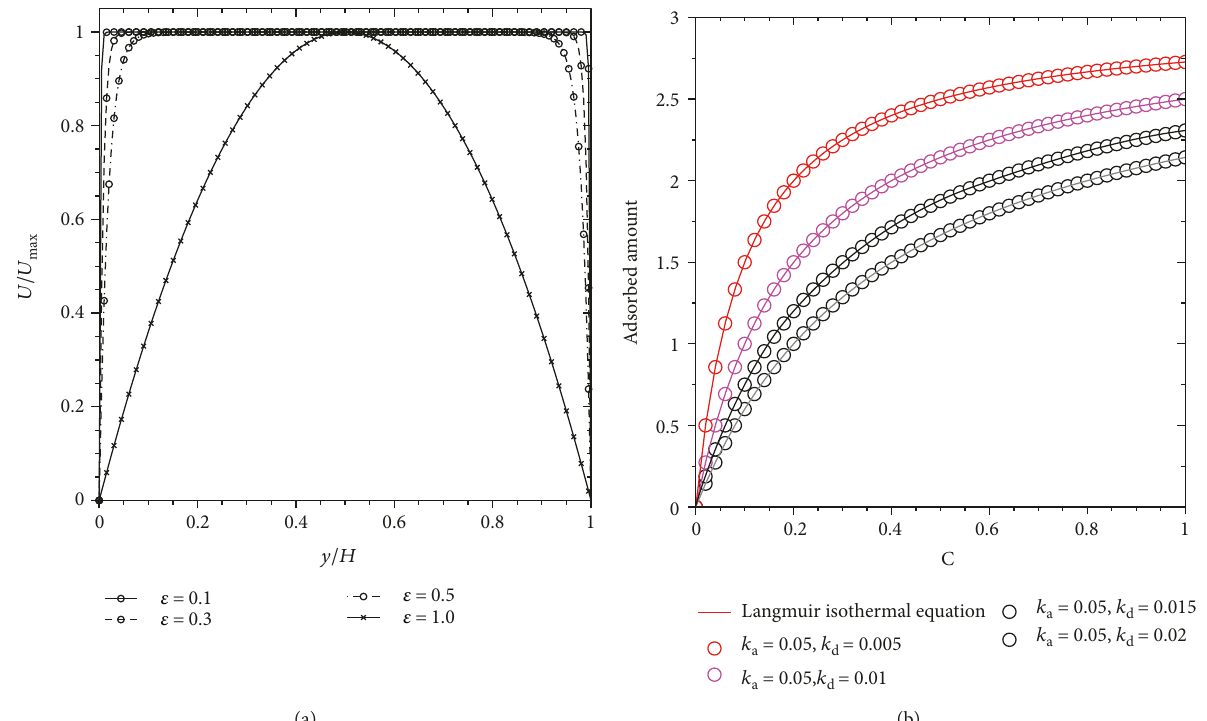
Figure 2: Simulation results of porous fl ow between plates. (a) The velocity pro fi les of a single-component fl uid fl ow without mass transfer, ignoring the nonlinear drag force term. Note that velocity u was normalized by the maximum velocity at the centerline of the channel u max . (b) The relationship between the concentration and the adsorbed amount of coupled fl ow with both fl uid fl ow and gas di ff usion. The results (symbols) are in good agreement with the analytical solution